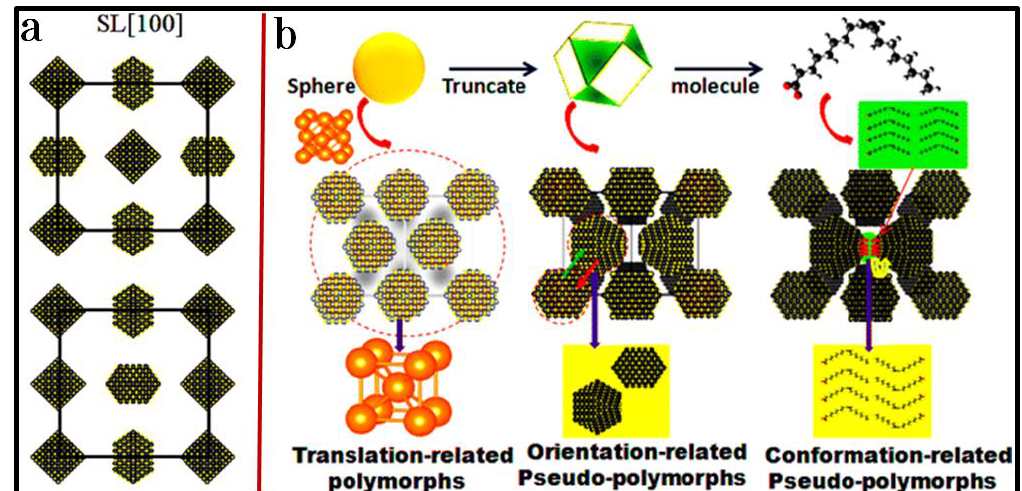
Figure 8. ( a ) Two non-degeneration shape-based superlattice pseudo-polymorphs of fcc superlattice made up of truncate PbS NCs as projected in SL [100], which yield identical sets of SAXS and WAXS patterns. The top and bottom of inset ( a ) include a C 4 h and C 2 h symmetry, respectively; ( b ) three types of fcc superlattice pseudo-polymorphs, including translation-, orientation- and conformation-related ones. Copyright of the American Chemical Society [37].